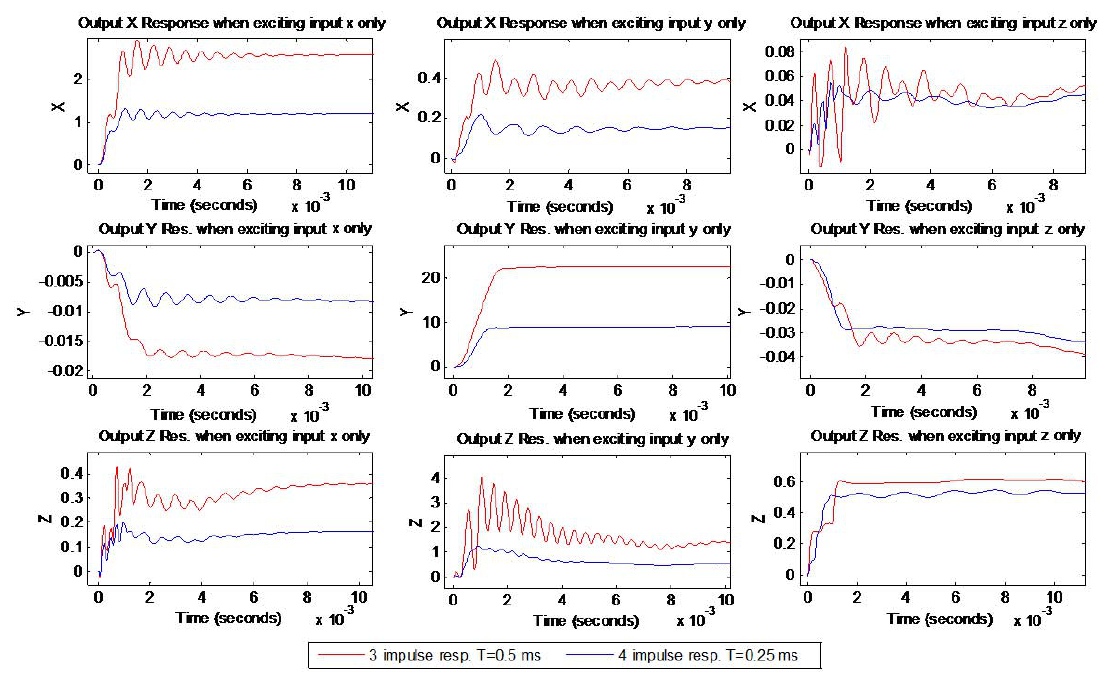
Figure 5. Compensated output responses for three and four impulse shaper designs—simulation.